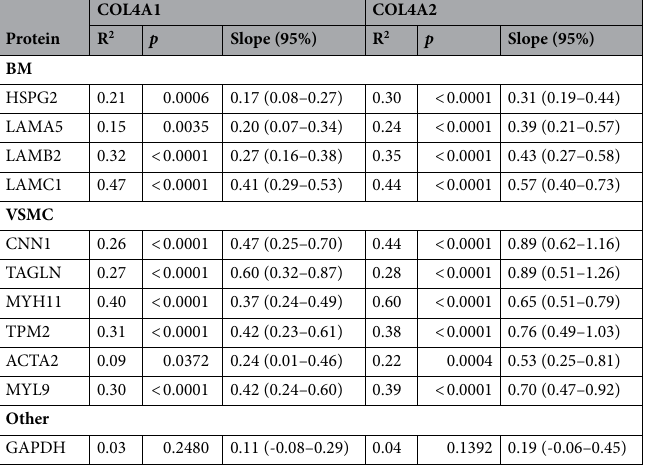
and found significant correlations between COL4A1/A2 and BM components as well as VSMC markers (Table 1 and Supplemetary Fig. 3). The human COL4A1/A2 locus harbors alleles with moderate association to AAA risk. True disease-associated genetic risk variants may be overlooked as a consequence of stringent statistical criteria used in GWAS. Instead, we here used a hypothesis-driven approach based on the largest available AAA GWAS